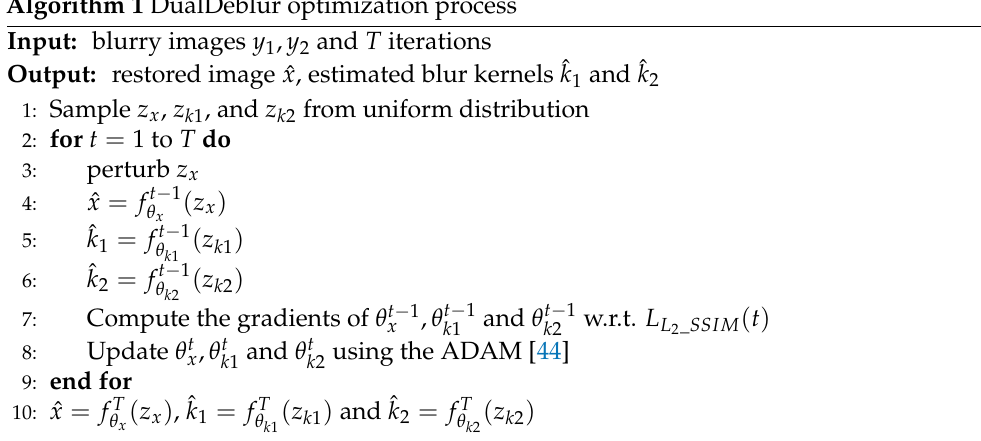
Algorithm 1 DualDeblur optimization